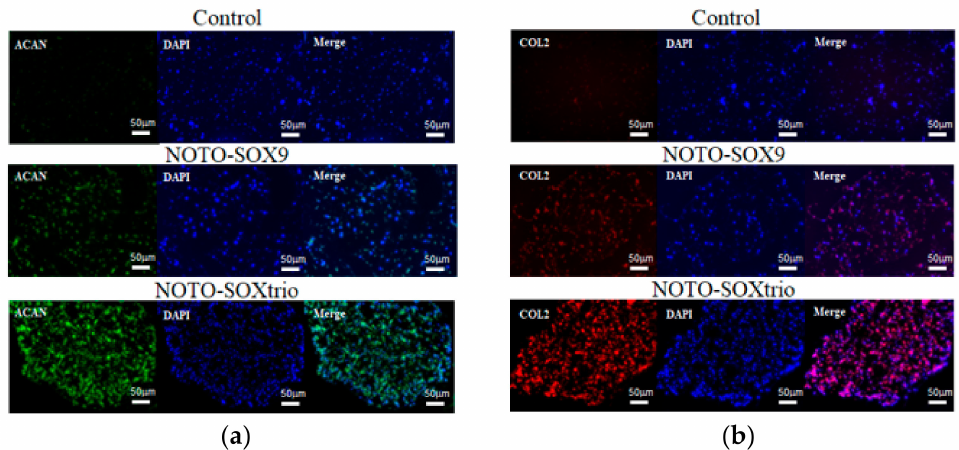
Figure 2. Histological analysis of NHDFs. NHDFs were cultured for 4 weeks in a chromogenic medium containing alginate beads: ( a ) HE-staining; ( b ) Safranin-O staining. Control indicates empty pcDNA3.1 transfected NHDFs.